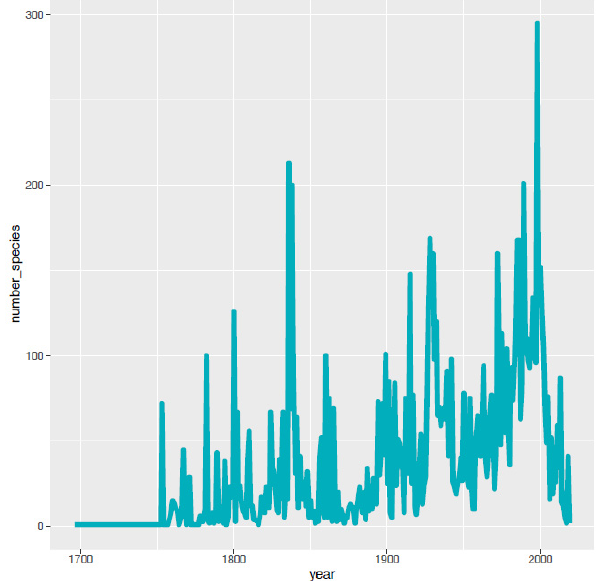
8 of 16 Figure 4. Summary of taxonomic activities of plant experts in South Africa. 3.2. Prediction of the Richness of Potentially Unknown Species This number was predicted in two ways: experts’ opinions and statistical modeling.